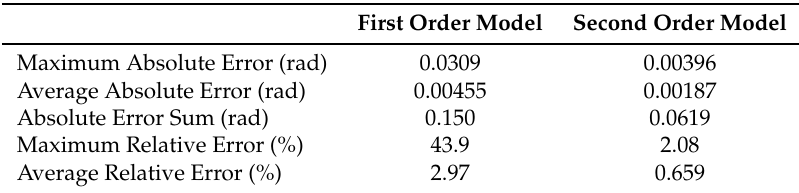
Table 2. Motor First and Second Order Models Errors